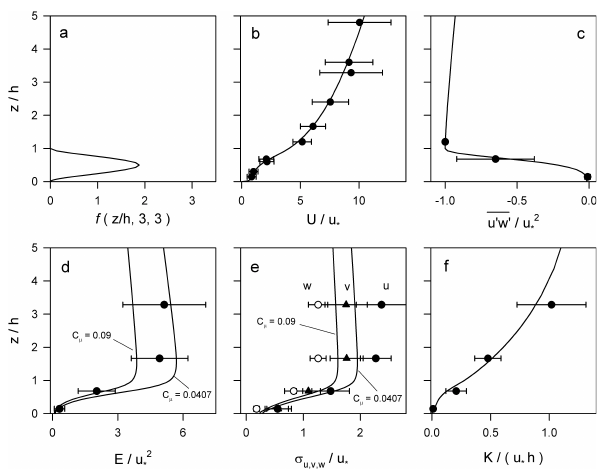
Fig. 2. Normalized vertical profile of foliage density (a) assumed in the model and normalized experimental (symbols) and modelled (lines) turbulence statistic within and above Pine Scots forest at Hyyti¨al¨a under near-neutral conditions: (b) the mean wind speed, (c) momentum flux, (d) turbulent kinetic energy, (e) standard devia- tion of wind speed components, and (f) eddy diffusivity. Error bars present ± 1 standard